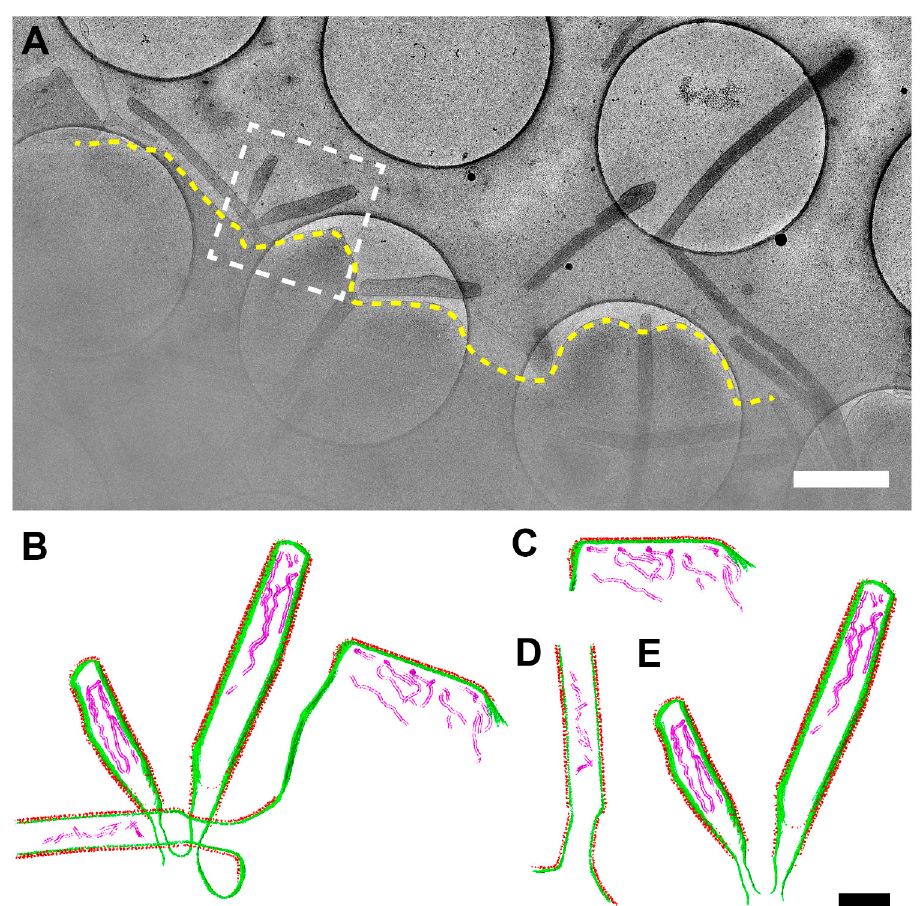
Figure 8. RSV assembly steps revealed by cryo-ET. ( A ) Representative cryo-EM images of RSV-infected cells. Note the assembly site indicated by the dashed white box and the released viral particles. The dashed yellow line indicates the cell plasma membrane. ( B ) Segmentation of the assembly site indicated in the white dashed box in ( A ), illustrating initiation ( C ), elongation ( D ), and scission ( E ) events. See also Supplementary Movie S1. Green is membrane, red is glycoprotein, and magenta is the RNP complex. Scale bars are 1 µ m ( A ) and 200 nm ( B – E ).